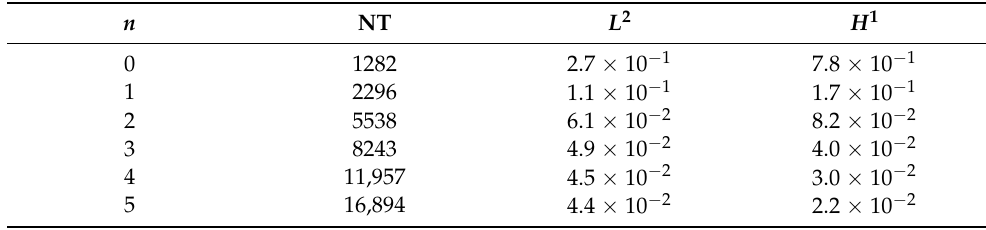
Table 5. Error in L 2 norm and H 1 seminorm for example 2 obtained with the gradient recovery error